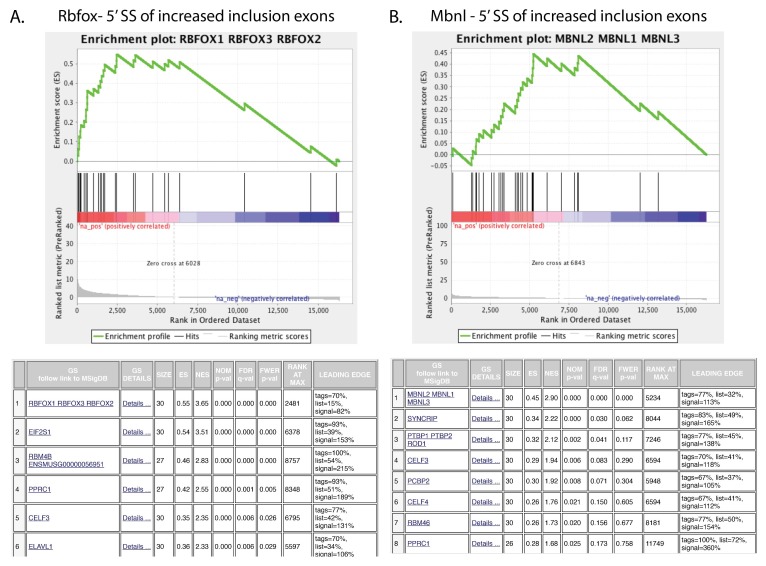
Positive control sets to confirm the motif-based identification of regulated events in vitro and in vivo by their CisBP-RNA fingerprint in GSEA.GSEA plots showing enrichment of top CisBP-RNA motifs for the indicated splice factors near the skipped exons of the events regulated in the published gene sets (Rbfox2 shRNA in ES cells in vitro from Jiangi M et al; Mbnl1 in heart of KO mice from Wang ET et al.).